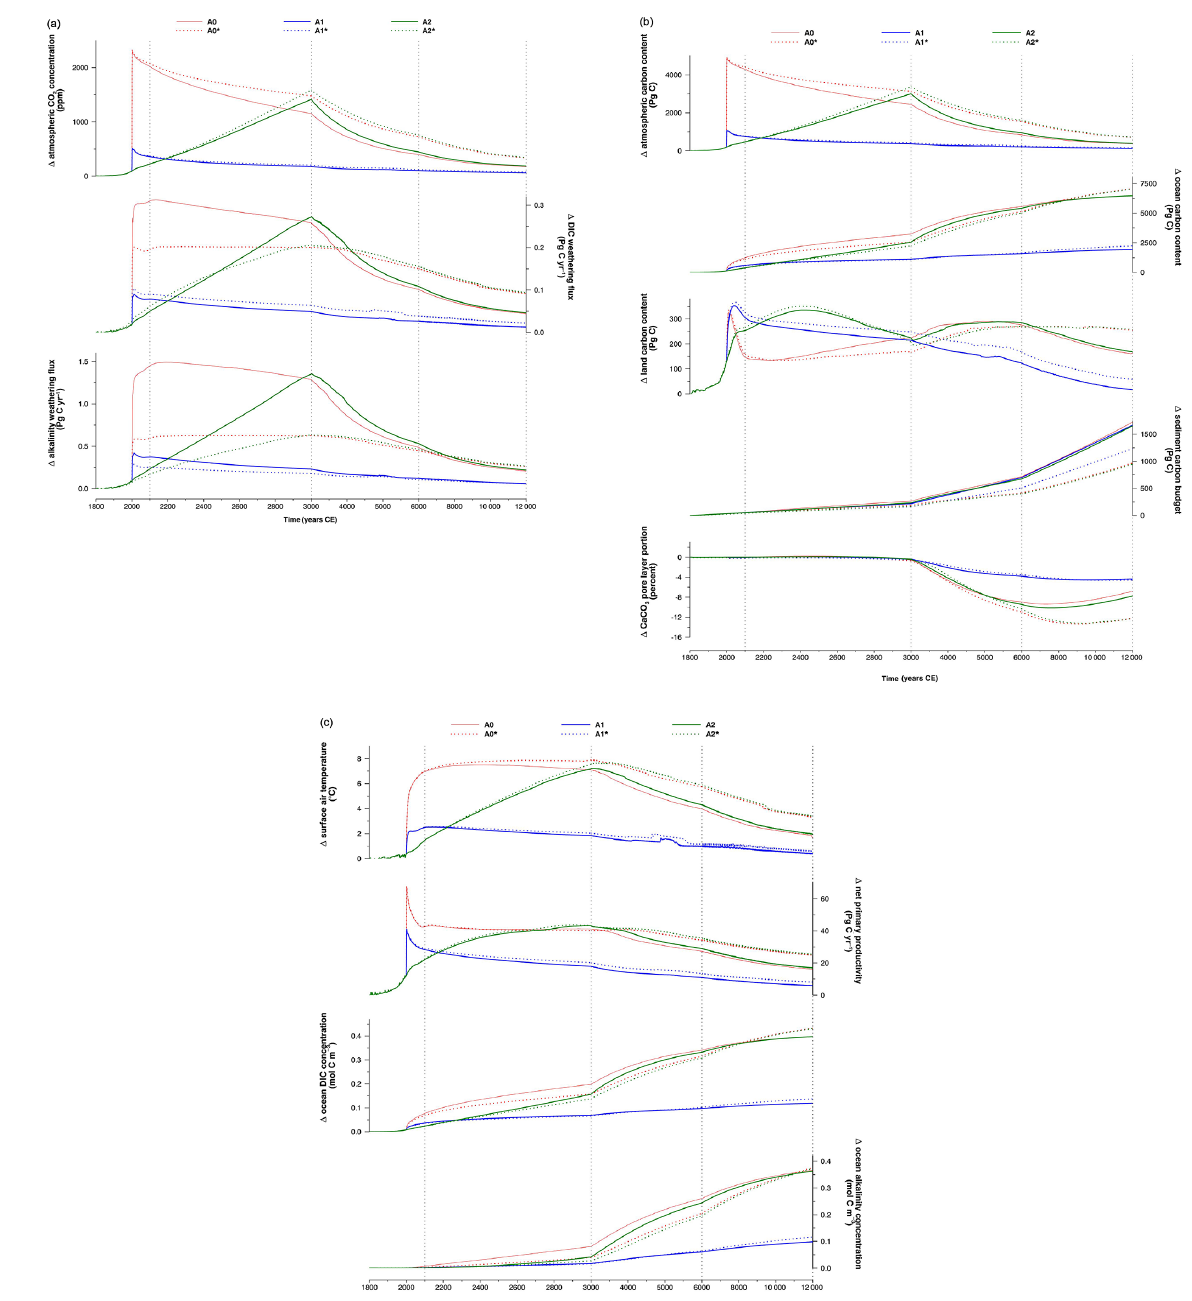
Figure 3. Time series of simulated changes in various globally averaged or summed model outputs for Group A scenarios, compared with pre-industrial steady-state values. These scenarios include A0 (high-amplitude pulse), A1 (low-amplitude pulse), A2 (gradual emissions), and their zero-dimensional counterparts (indicated by the “ ∗ ” symbol). Shown here are (from top to bottom): (a) atmospheric CO 2 concen- trations, and weathering fluxes of DIC and alkalinity; (b) global carbon differences for atmospheric, ocean, land, and sediment reservoirs; and (c) surface air temperature, net primary productivity, and oceanic concentrations of DIC and alkalinity. Note the different scales along the time axis, which change at years 3000 and 6000. Vertical dashed lines are used to indicate times for which results are shown in Figs. 4, 5, and 7. The curves shown here represent experiments A0 (red), A1 (blue), and A2 (green), with dashed colored lines representing the zero-dimensional equivalent model